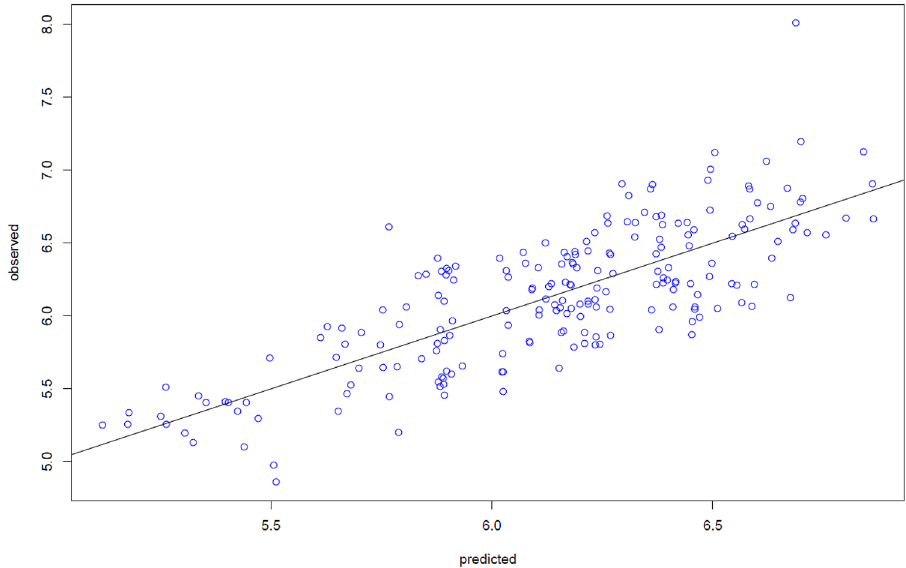
Fig. 4 Visualization of the model fit, predicted versus measured log (IP 180 Oil) of the Wolfcamp horizontal wells. The diagonal line indicates where the predicted and observed log IP 180 Oil values would be